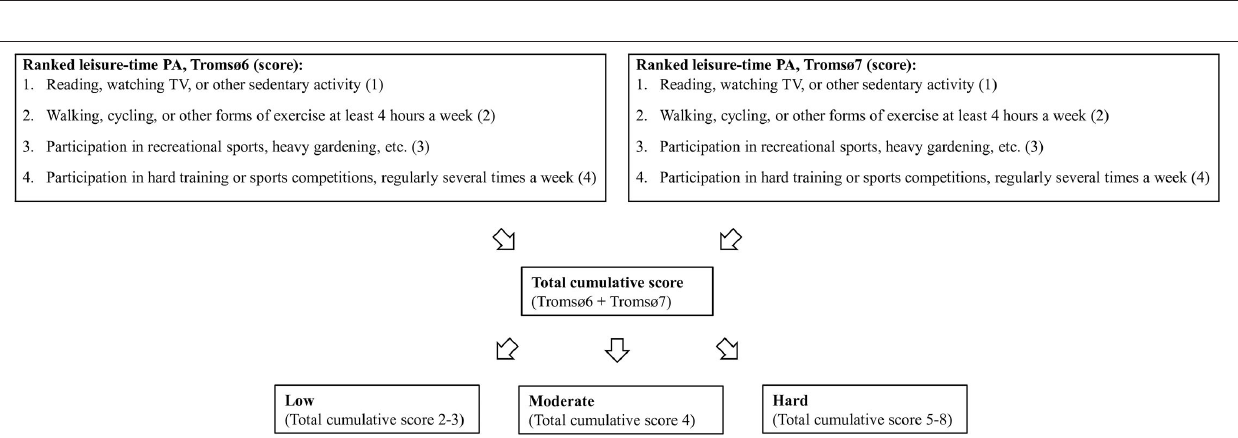
(aortic valve mean gradient ≥ 15 mmHg) by continuous Doppler (24), (b) presence of mitral or (c) aortic regurgitation detected by color Doppler imaging with mitral insufficiency graded according to regurgitant jet area > 4 cm 2 (25), and aortic regurgitation graded by vena contracta width by color M-mode divided by of LV outflow tract diameter ( > 30% graded as moderate or higher) (25), and/or (d) mitral E-wave > 1 m/s) by pulsed Doppler (26).